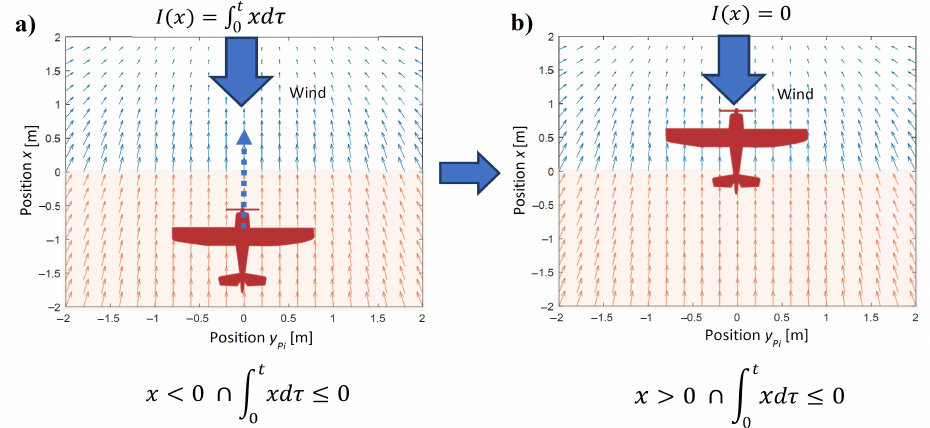
Figure 3. Switching a value of I ( x ) according to the relative position of a UAV in respect to the tracked point and direction of wind gust. ( a ) the value of I ( x ) is different than zero, ( b ) the value of I ( x ) equals